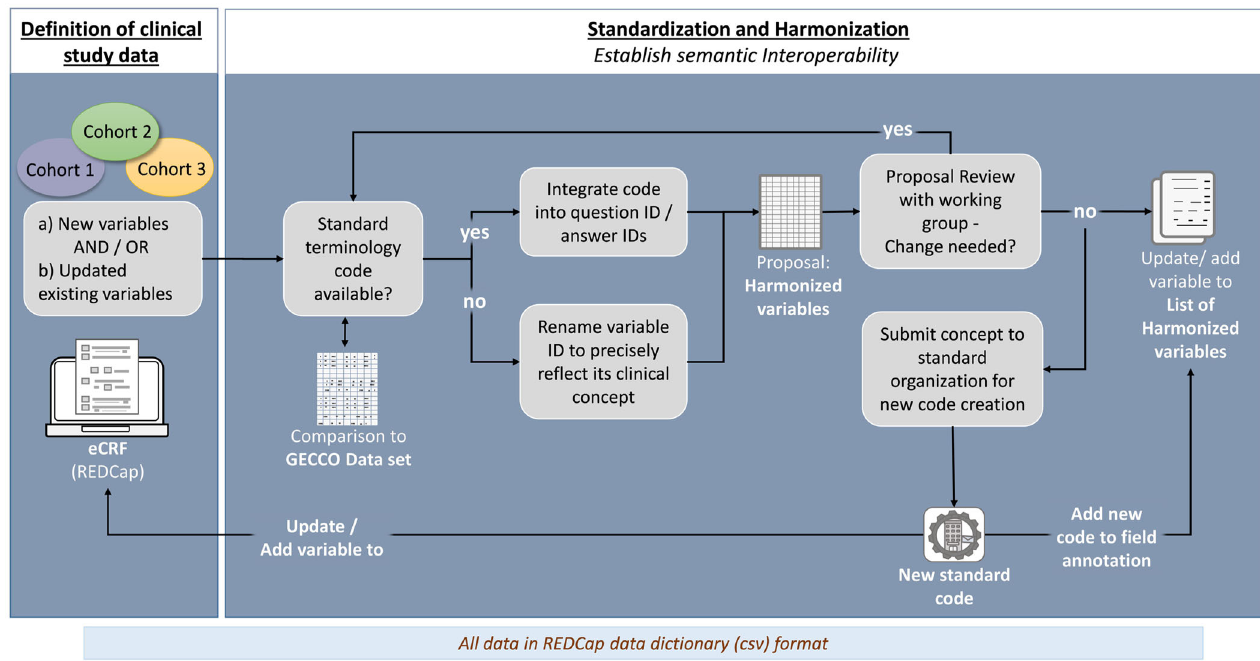
Fig. 5 Standardization and harmonization work fl ow. The diagram shows the different steps of the standardization and harmonization process in